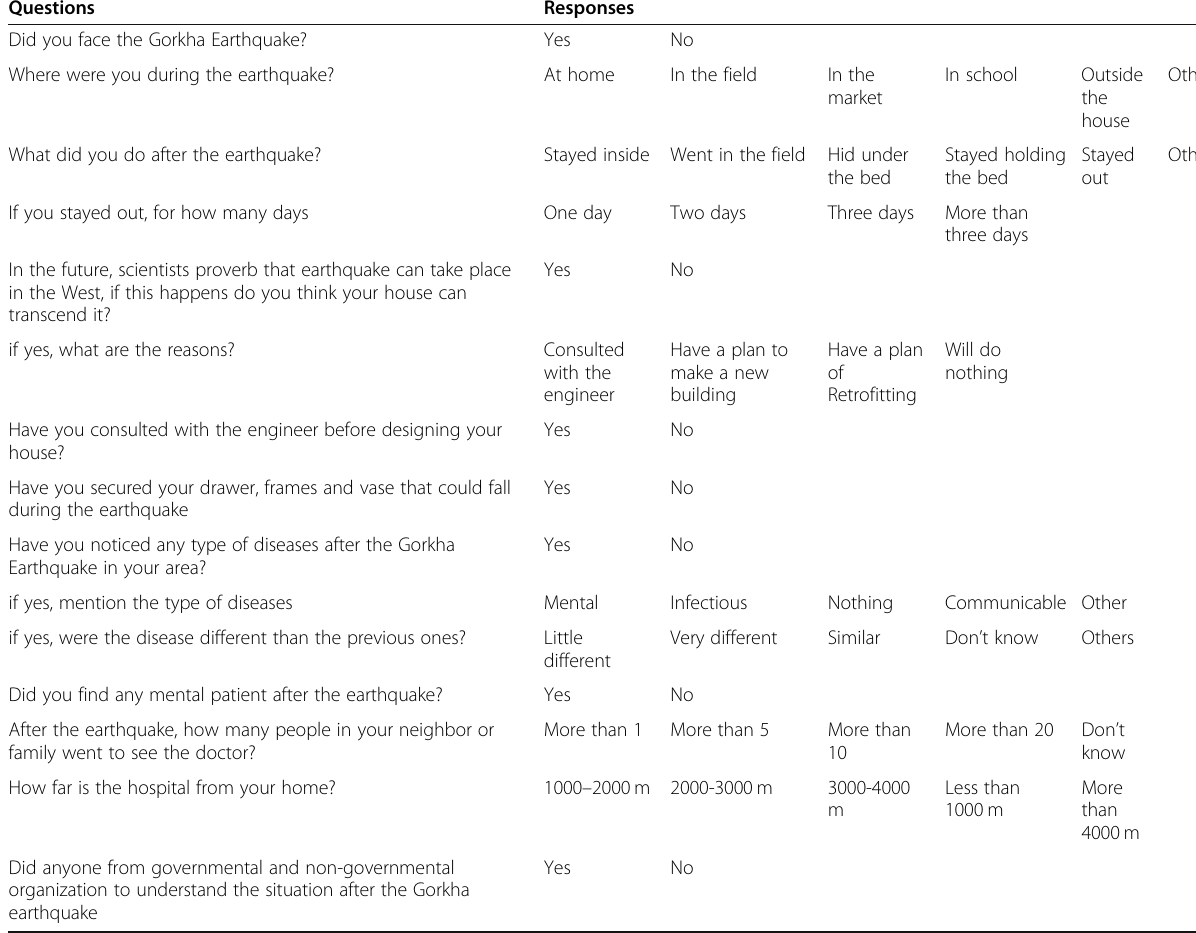
Table 1 Few questions related to the 2015 Gorkha Earthquake and readiness behaviour